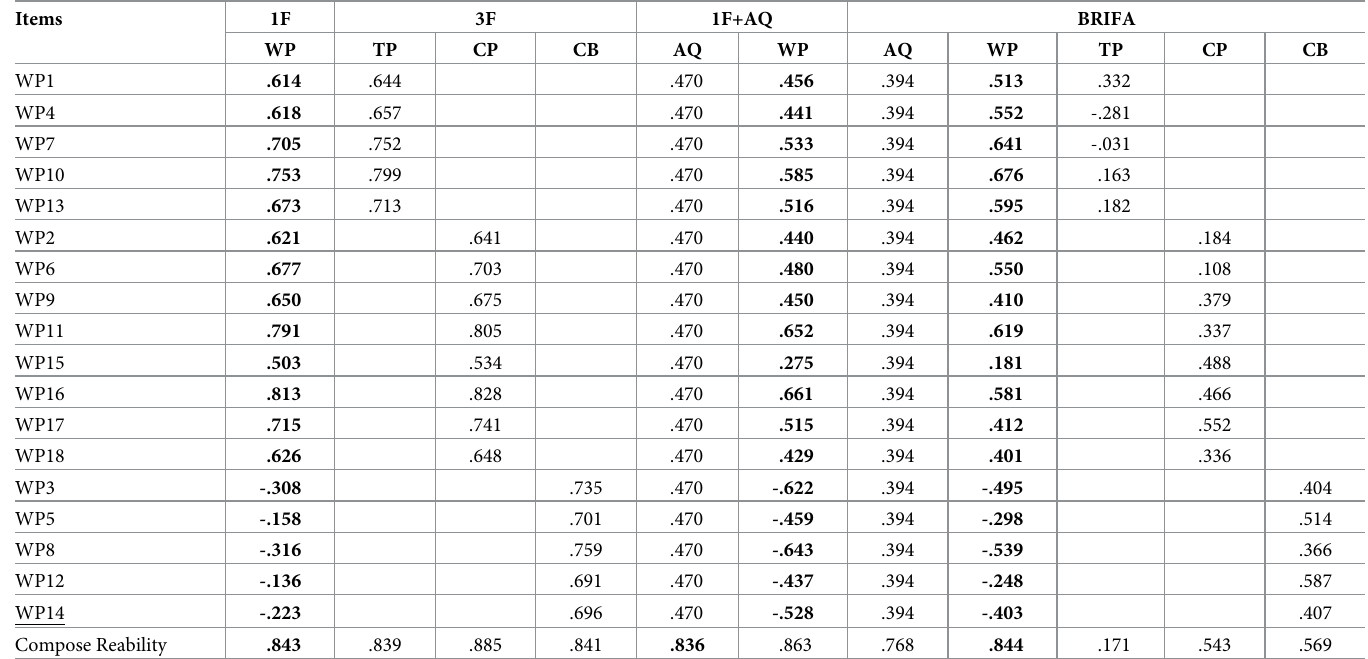
Table 4. Estimated factor loading for competing models.